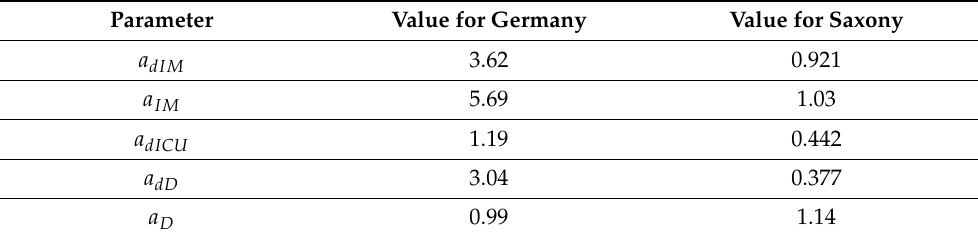
Table A4. Residual errors of observables. We present the residual errors of fitting our model to the